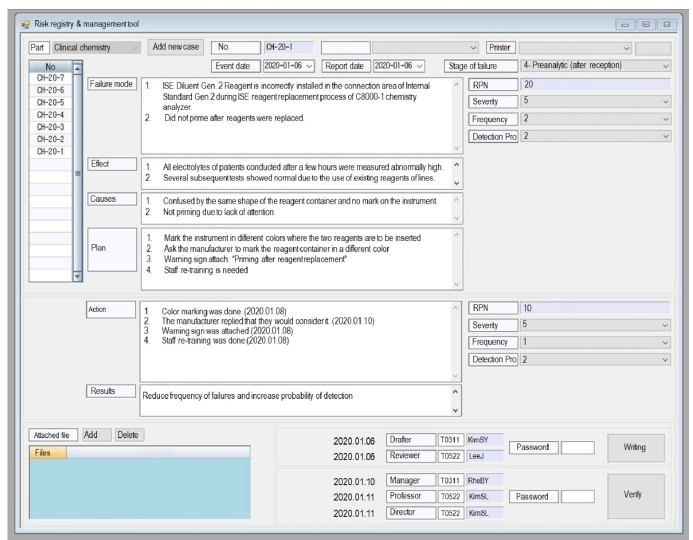
Figure 2. Example of computerized risk registry and management tool (RRMT) embedded in the laboratory information system of our laboratory. Abbreviation: RPN, risk priority